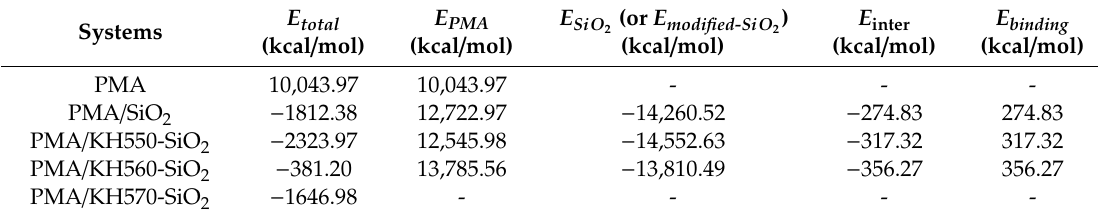
Table 2. Binding energy of PMA / SiO 2 and PMA / modified-SiO 2 composites.